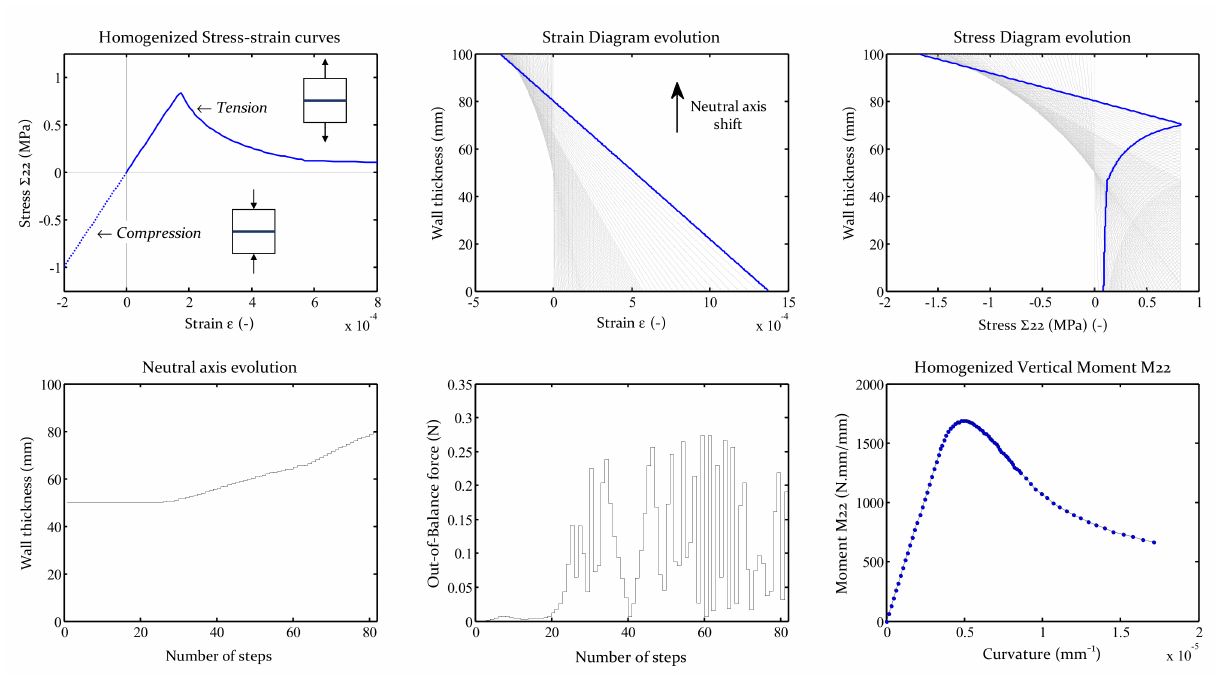
Figure 8. Procedure for integrating the homogenised vertical stress–strain curves on the masonry thickness aiming to obtain the homogenised vertical bending moment curve for the benchmark